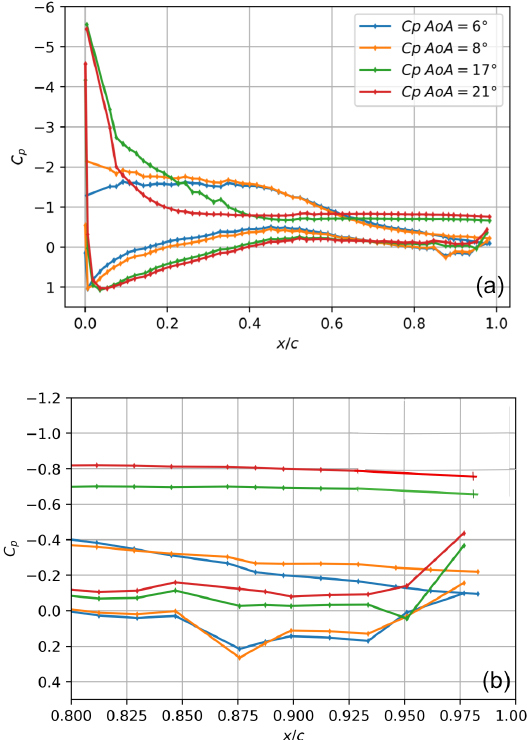
Figure 9. (a) Pressure coefficient C P average on the three lines of pressure taps for AoA = 6 ◦ , AoA = 8 ◦ , AoA = 17 ◦ and AoA = 21 ◦ . (b) Zoomed-in view of the trailing edge.